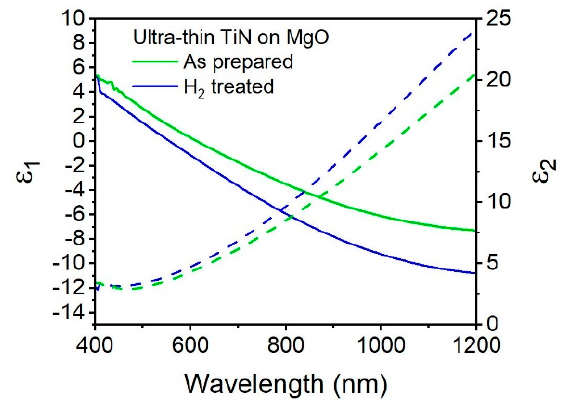
Figure 4. Real (solid lines) and imaginary (dashed lines) values of permittivity of ultrathin TiN (100 cycles) on MgO as prepared (green) and after hydrogen plasma anneal (blue).